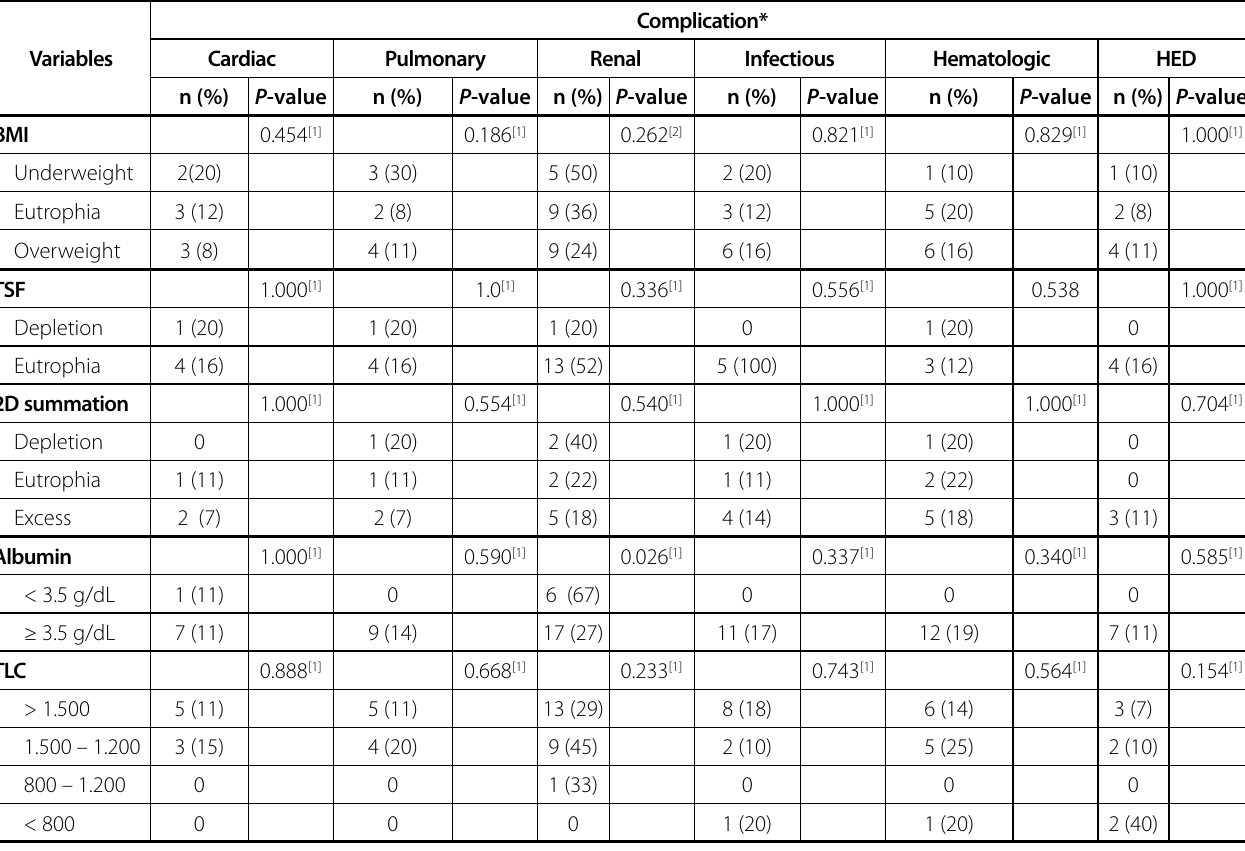
Table 4 – Association between the presence of clinical complications in the postoperative period of cardiac surgery and the nutritional status